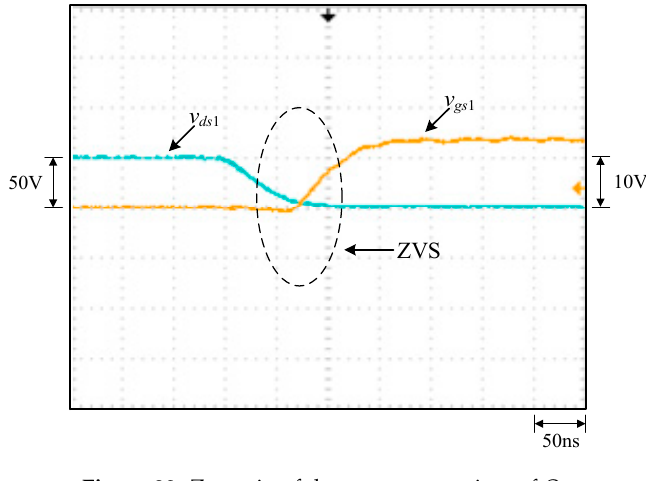
Figure 19. Measured waveforms at rated load: (1) V in ; (2) V o .